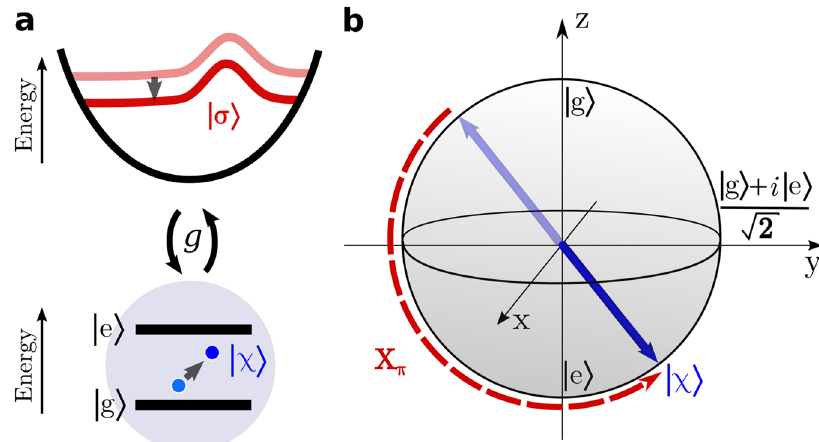
Fig. 1 Model system. a Ideal two-level system ( bottom ) interacting with a harmonic oscillator ( top ). b Bloch vector representation of the qubit state χ j i and an example X π